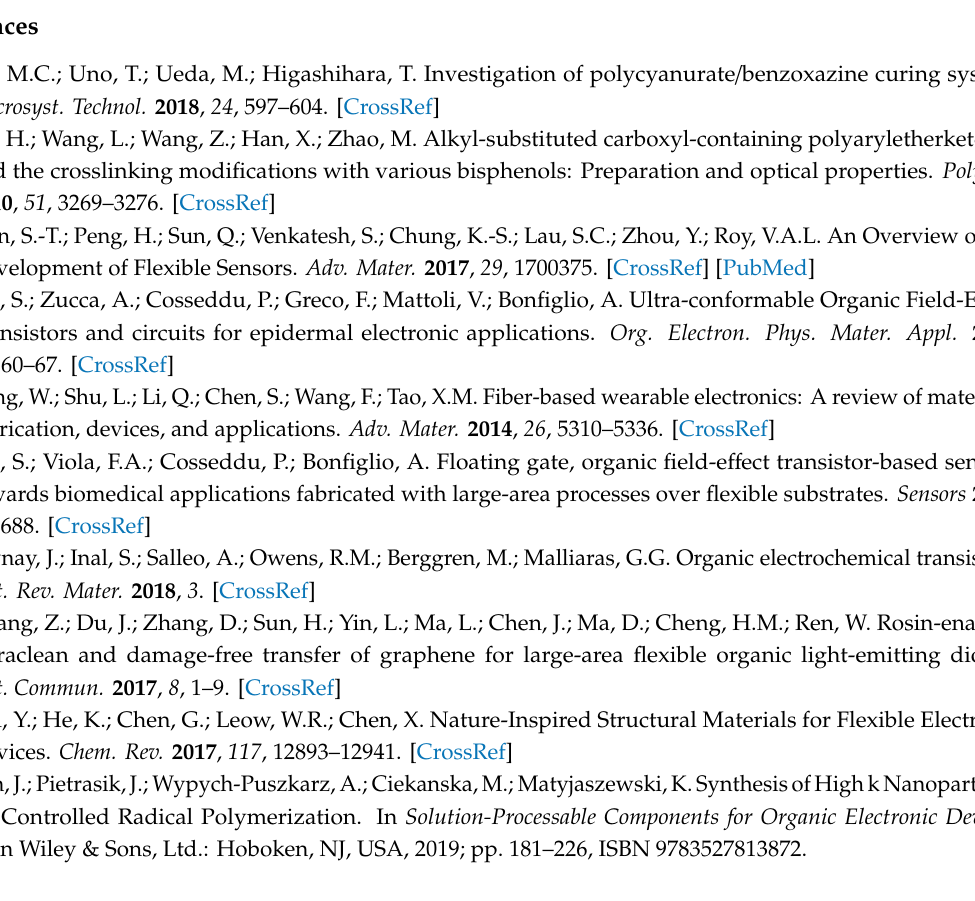
Figure S1: 1 H NMR spectrum of 4,4 (cid:48) -dimethyl-2,2 (cid:48) -bipyridine (bpy) in D 2 O; Figure S2: 1 H NMR spectrum of aminopropyl terminated poly(dimethylsiloxane) (PDMS) in CDCl 3 ; Figure S3: 1 H NMR spectrum of 2,2 (cid:48) -bipyridine-terminatedpoly(dimethylsiloxane)(bpyPDMS)inCDCl 3 ; FigureS4: FT-IRspectraofbpy, bpyPDMS, and PDMS in the range of 1500–2000 cm − 1 ; Figure S5: Geometry of optimized coordination compounds (Me: Mn 2 +